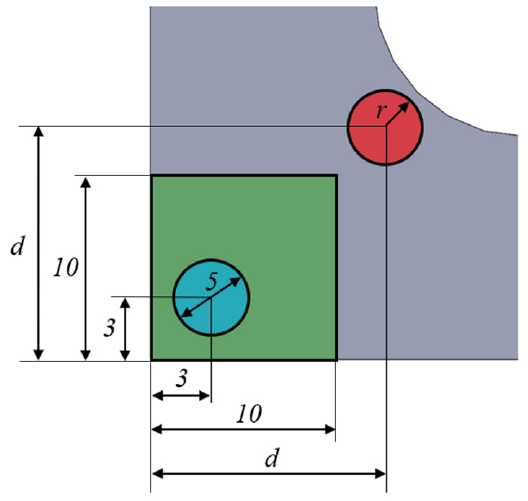
Figure 12. Measurement region on geometry A (green square), indicating the position and dimen- sions of the strain rosette (blue circle) and the opening (red circle). Units are in mm.